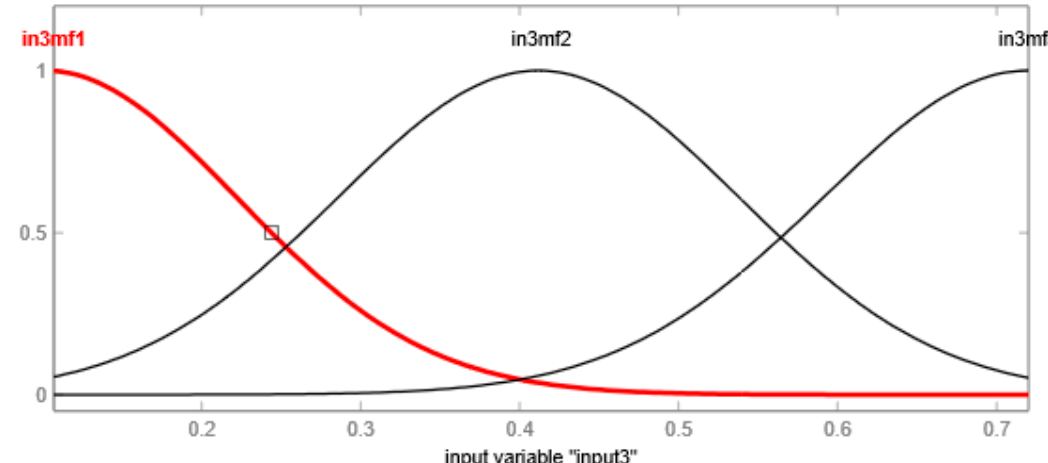
Figure 12. Membership function for input variable 3 i.e., Flank Pain.